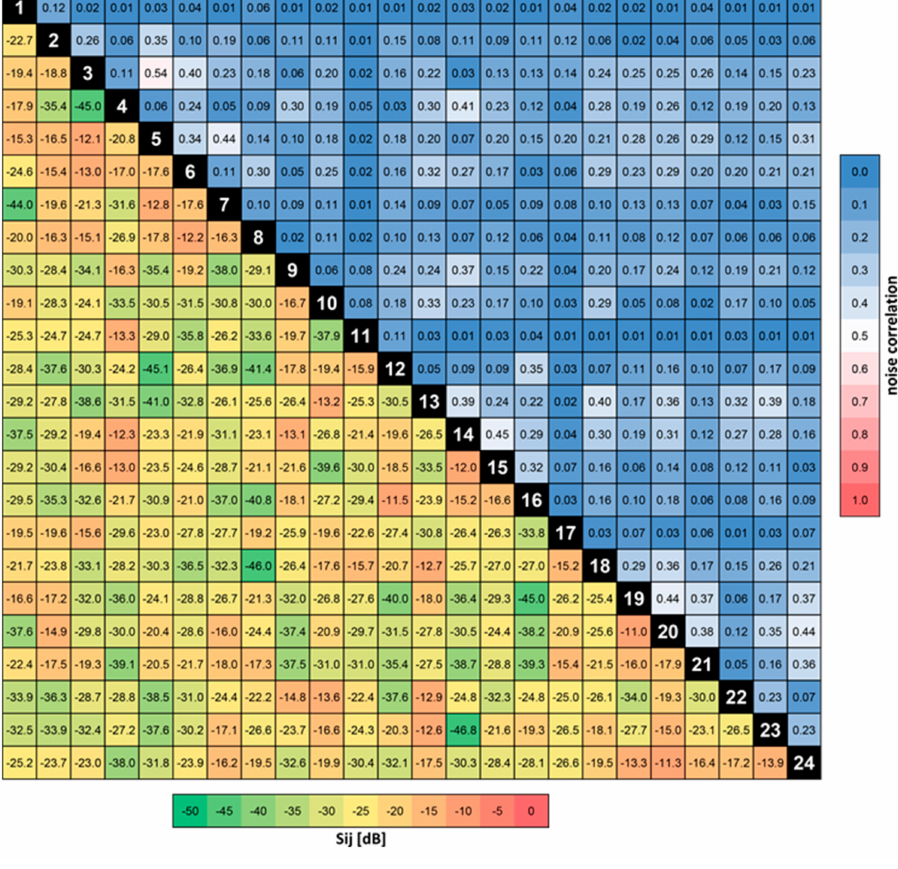
Figure 4. Radio frequency scattering parameters and noise correlation matrix. The lower triangle of the matrix shows the S-parameters, the upper triangle contains the noise correlation values between channels. In both cases the RF coil was loaded with the head-like gel